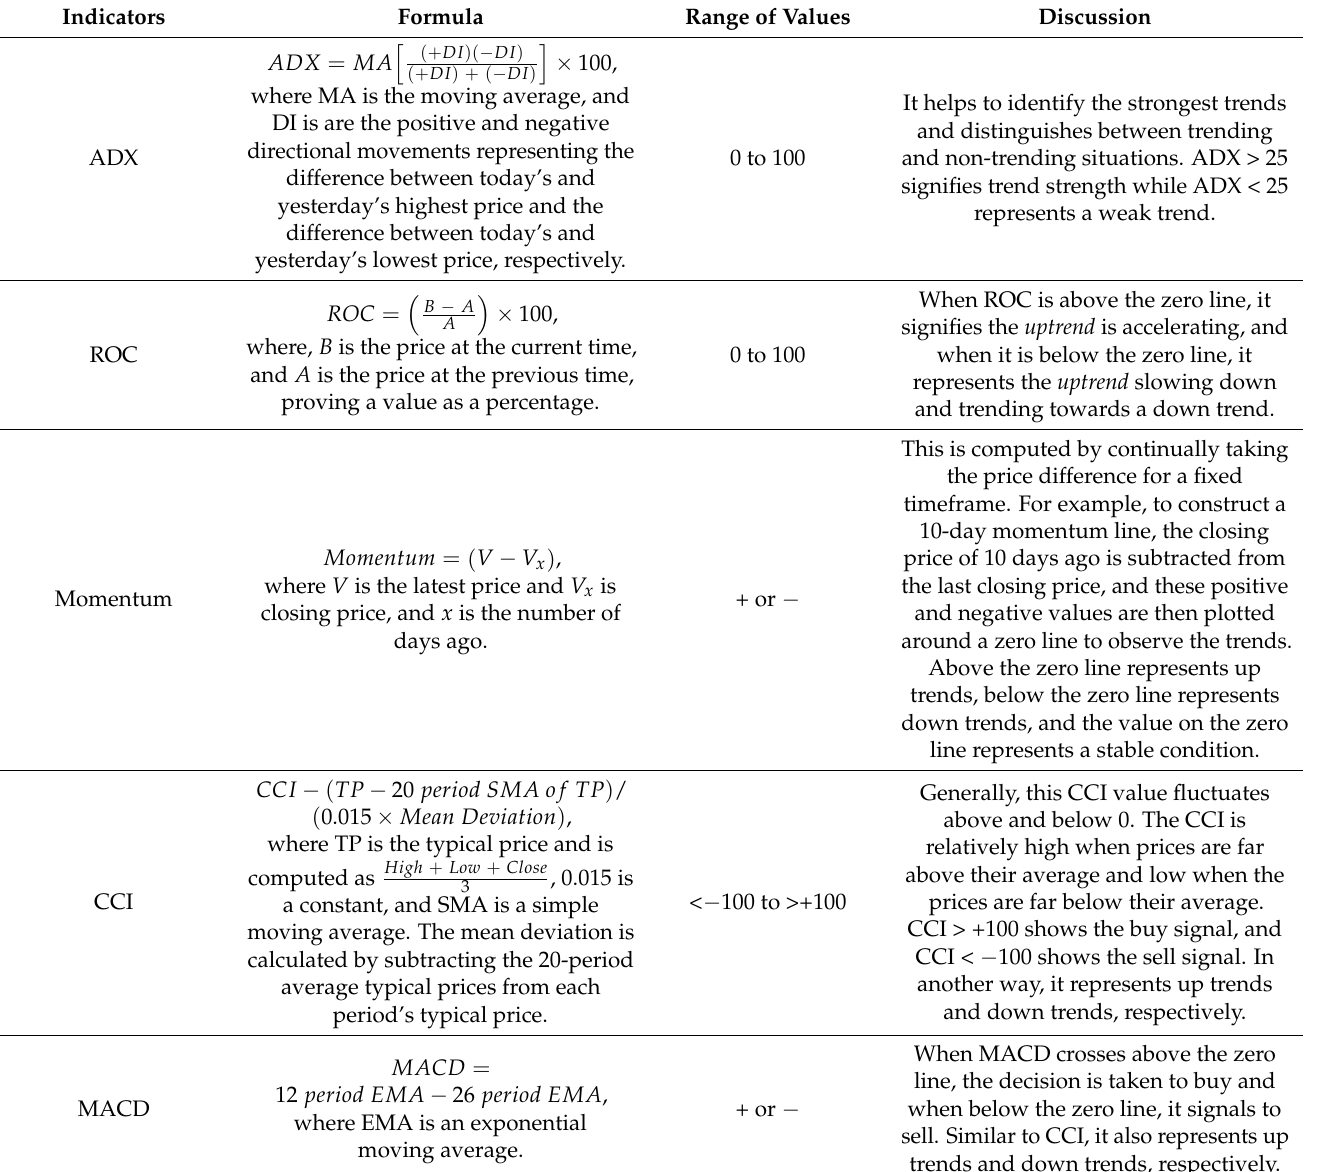
Table 2. Indicators used for trend analysis